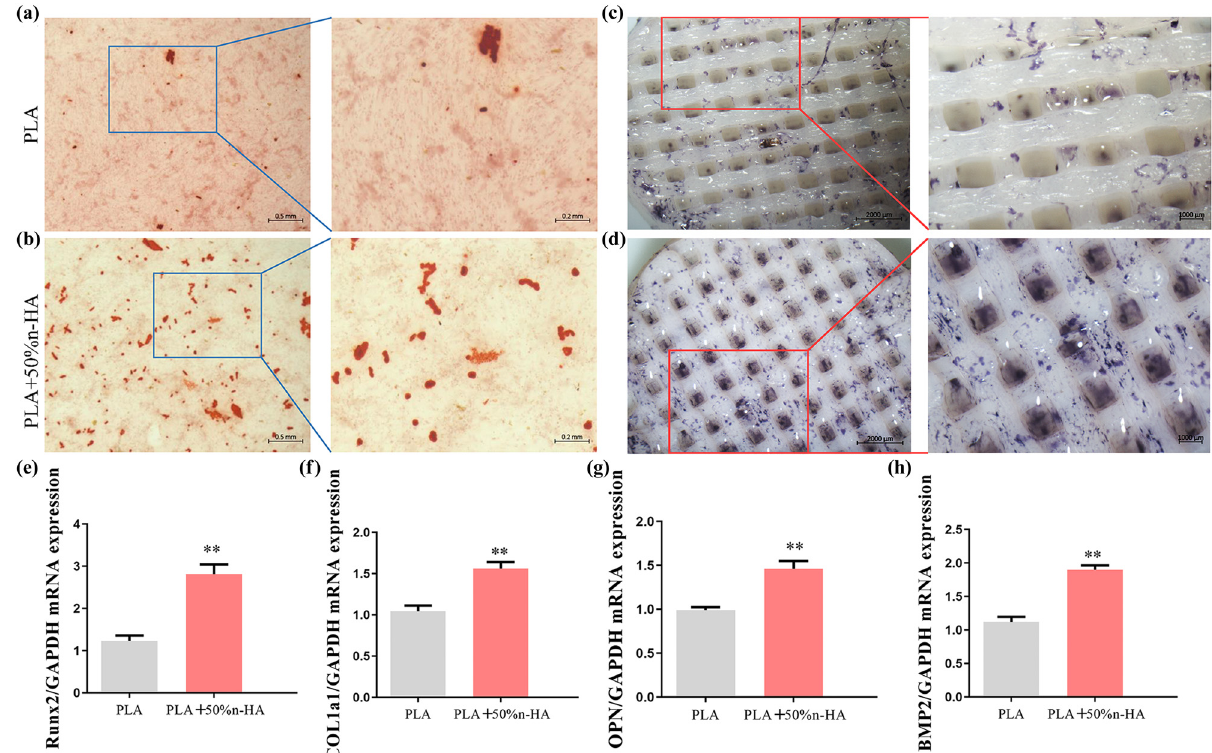
Figure 7: Osteogenic induction of 3D - printed sca ff olds. ( a ) Mineralized extracellular matrix production of BMSCs on PLA sca ff olds; ( b ) alizarin red S staining of BMSCs on PLA/n - HA composites sca ff olds; ( c ) alkaline phosphatase activity of BMSCs was conducted on PLA sca ff olds; ( d ) results of induction e ff ect of BMSCs of alkaline phosphatase staining on PLA/n - HA composites sca ff olds ( bar, low power = 0.5 mm; high power = 0.2 mm ) ; and ( e – h ) the expression of osteogenic genes in BMSCs on PLA and PLA/n - HA composites sca ff olds. Runt - related transcription factor 2 ( Runx2 ) , type I collagen a1 ( Col1a1 ) , osteopontin ( OPN ) , and bone morphogenetic protein - 2 ( BMP2 ) , ** p <